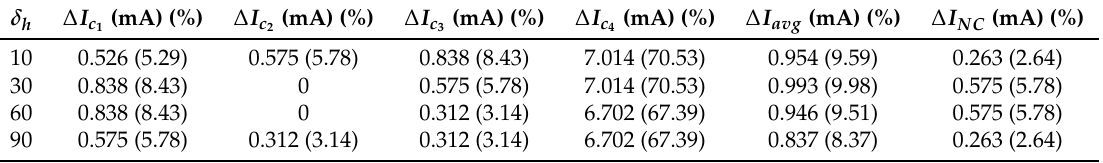
Table 5. Current reduction using the power ratio weighted sensor selection method on the HET in mA and percent of total power usage reduction for the different values of δ h